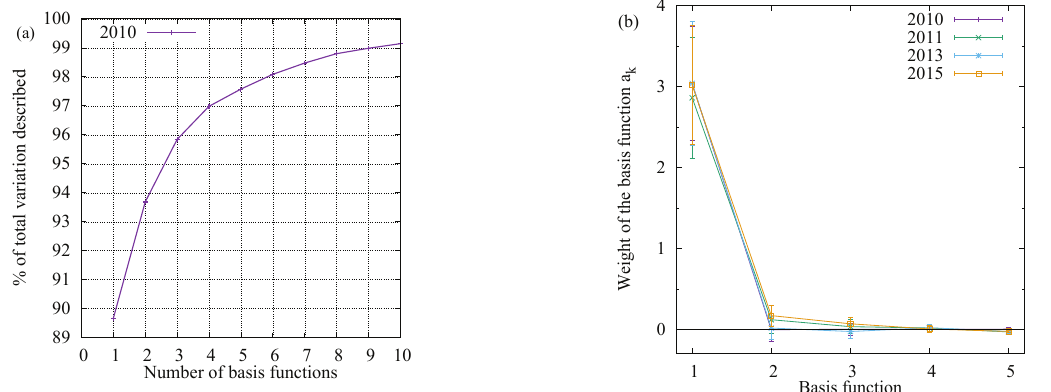
Figure 4. Cumulative percentage of variance described by basis functions ( a ), and mean value and standard deviation of the weights of basis functions ( b